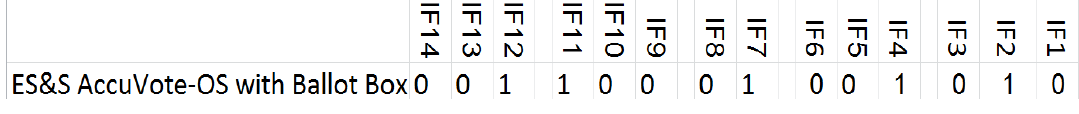
Figure 2: ES&S Accuvote JLP Table